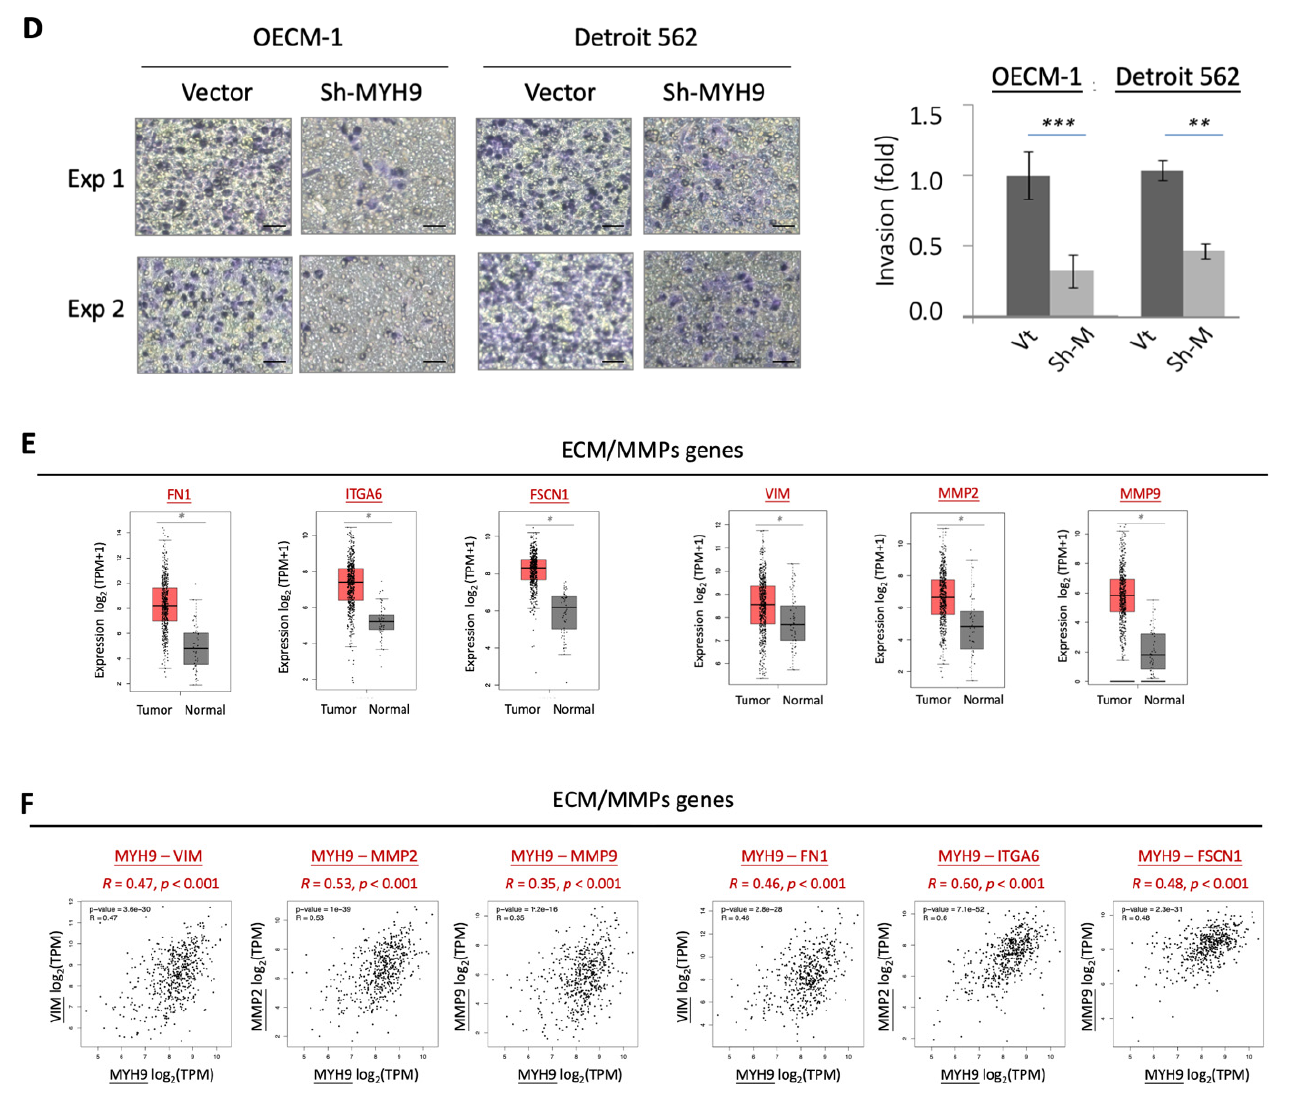
Figure 1. MYH9 promoted cell motility in HNC cells. ( A ) Examination of MYH9 expression level in five HNC cell lines (Detroit 562, BM2, OC3, C8, SAS, OECM-1) and two lines of keratinocytes (K2 and NOK) using the RT-qPCR method. ( B ) The efficacy of MYH9-shRNA knockdown in OECM-1 and Detroit 562 cells. The MYH9 protein level was determined by the western blot method to show the effect of MYH9 silencing. The GAPDH level was used as an internal control. ( C ) Transfection of MYH9-shRNA significantly decreased cell migration, as determined by an in vitro wound healing assay, scale bar 40 µ m. ( D ) Transfection of MYH9-shRNA suppressed cell invasion, as determined by a Matrigel invasion assay, scale bar 20 µ m. ( E ) Significant increases of ECM/MMPs-associated gene expressions in the tumor samples compared to normal samples. The gene expression data, including FN1, ITGA6, FSCN1, VIM, MMP2, and MMP9, were retrieved from the TCGA-HNSC dataset. ( F ) Correlative expressions between MYH9 and ECM/MMPs associated molecules FN1, ITGA6, FSCN1, VIM, MMP2, and MMP9 in the HNC tumor samples. The gene expression data were retrieved from the TCGA-HNSC dataset. All of the experiments were performed at least three times independently, and a typical result was shown. The error bars shown in the relevant figures indicated the standard deviation of the quantification results in all experiments. (*: p < 0.05, **: p < 0.01, ***: p < 0.001, t